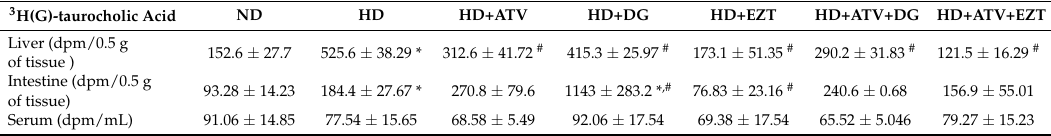
Table 3. Body distribution of 3 H(G)-taurocholic acid in hypercholesterolemic rats that received DG, ATV, EZT or their combinations.